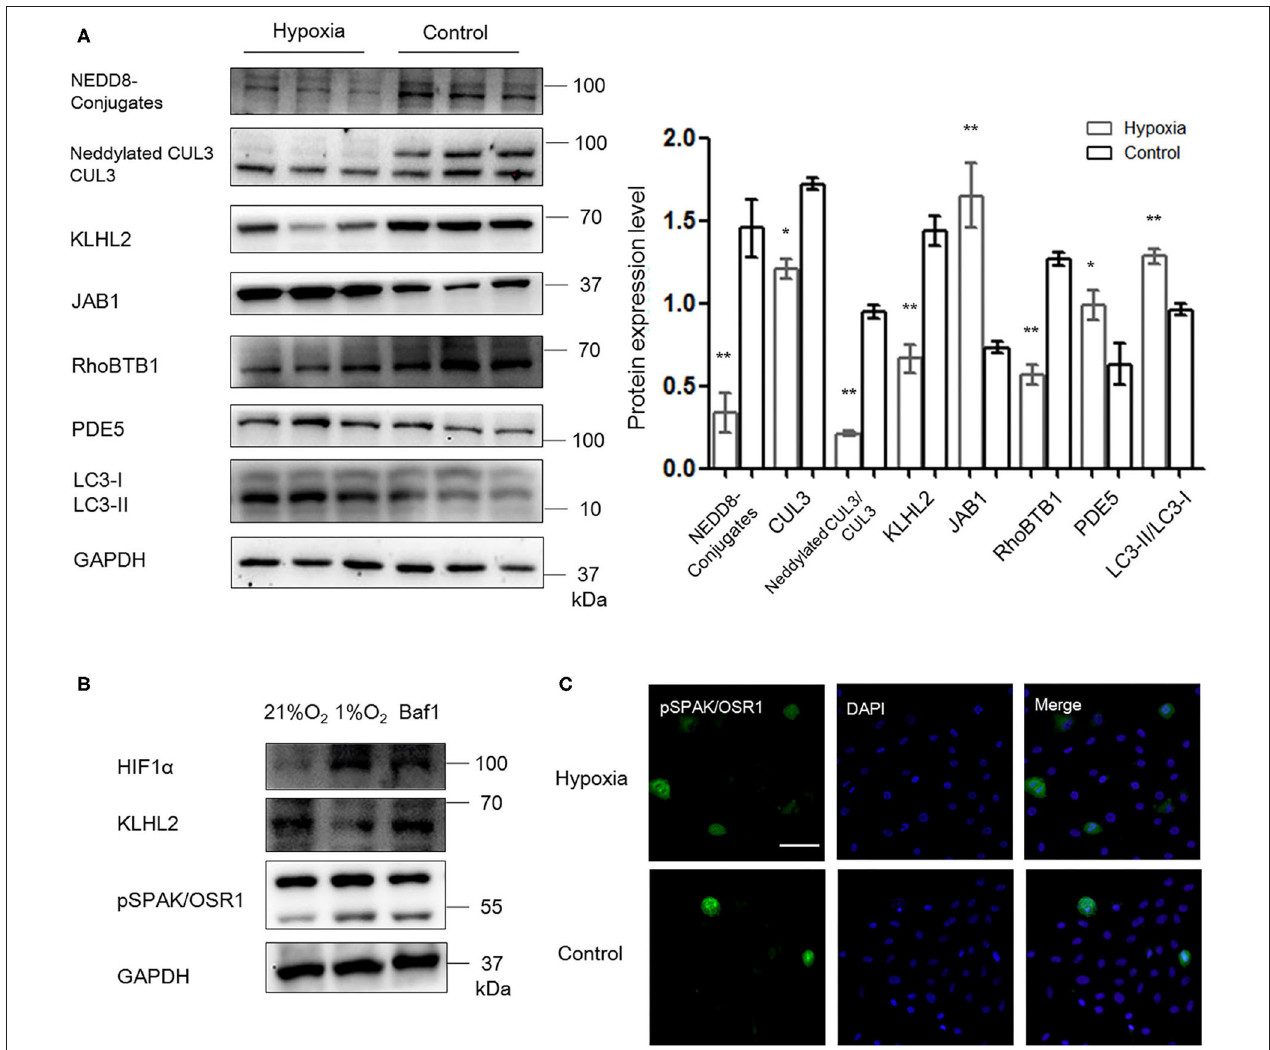
FIGURE 6 | Hypoxia downregulated the function of CRL3 and increased autophagy-mediated degradation of KLHL2 in MOVAS cells. (A) Protein levels of NEDD8 conjugates, the components of CRL3, including CUL3 abundance and neddylation, adaptors KLHL2 and RhoBTB1 with substrate PDE5, member of the COP9 signalosome JAB1, and autophagy marker LC3-II/LC3-I were detected in MOVAS cells of hypoxia and control groups. Expressions of these proteins in the MOVAS cells were all statistically significant ( t -test) after normalization to GAPDH among hypoxia ( n = 3) and control ( n = 3) group. (B) Representative immunoblots of the adaptor KLHL2, hypoxia-inducible factor HIF1 α , and downstream phosphorylated SPAK/OSR1 in MOVAS cells after administration with inhibitor of autophagy bafilomycin A1 (Baf1) under hypoxia ( n = 3). (C) Representative immunofluorescence images of subcellular localization of phosphorylated SPAK/OSR1 in MOVAS cells between the hypoxia and control groups. Scale bars: 100 µ m. Data are presented as the mean ± SEM (* p < 0.05 and ** p < 0.01).